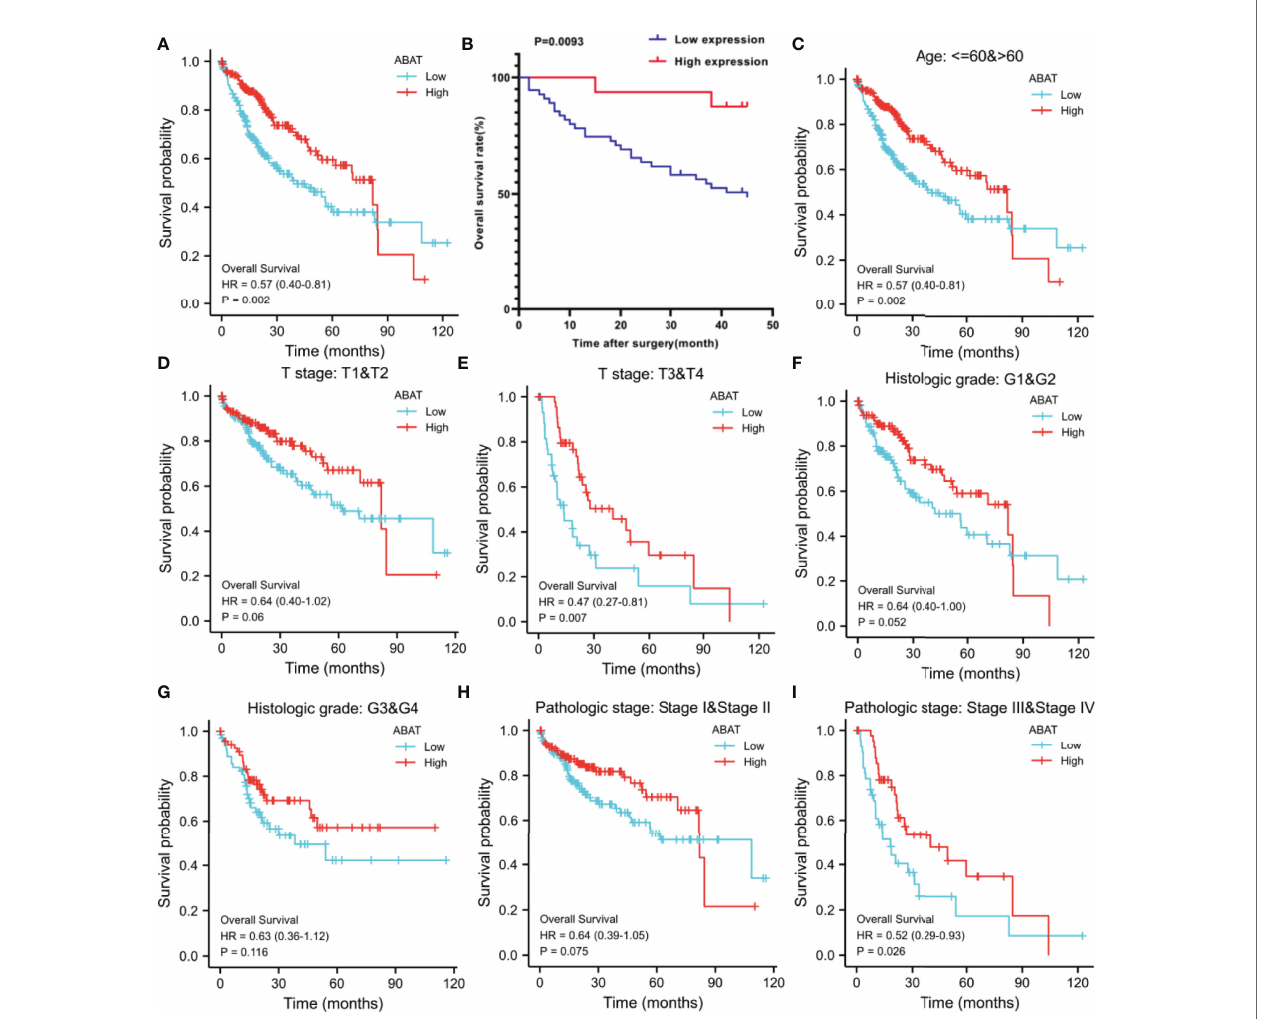
FIGURE 3 | Overall survival analyses with ABAT mRNA expression. (A) Survival curves in HCC for all cases from TCGA. (B) Survival curves in HCC with the results of qRT-PCR. (C) Age ≤ 60 or > 60, (D) T stage T1/T2, (E) T stage T3/T4, (F) Histologic grade G1/G2, (G) Histologic grade G3/G4, (H) Pathologic grade I/II, (I) Pathologic grade III/IV.